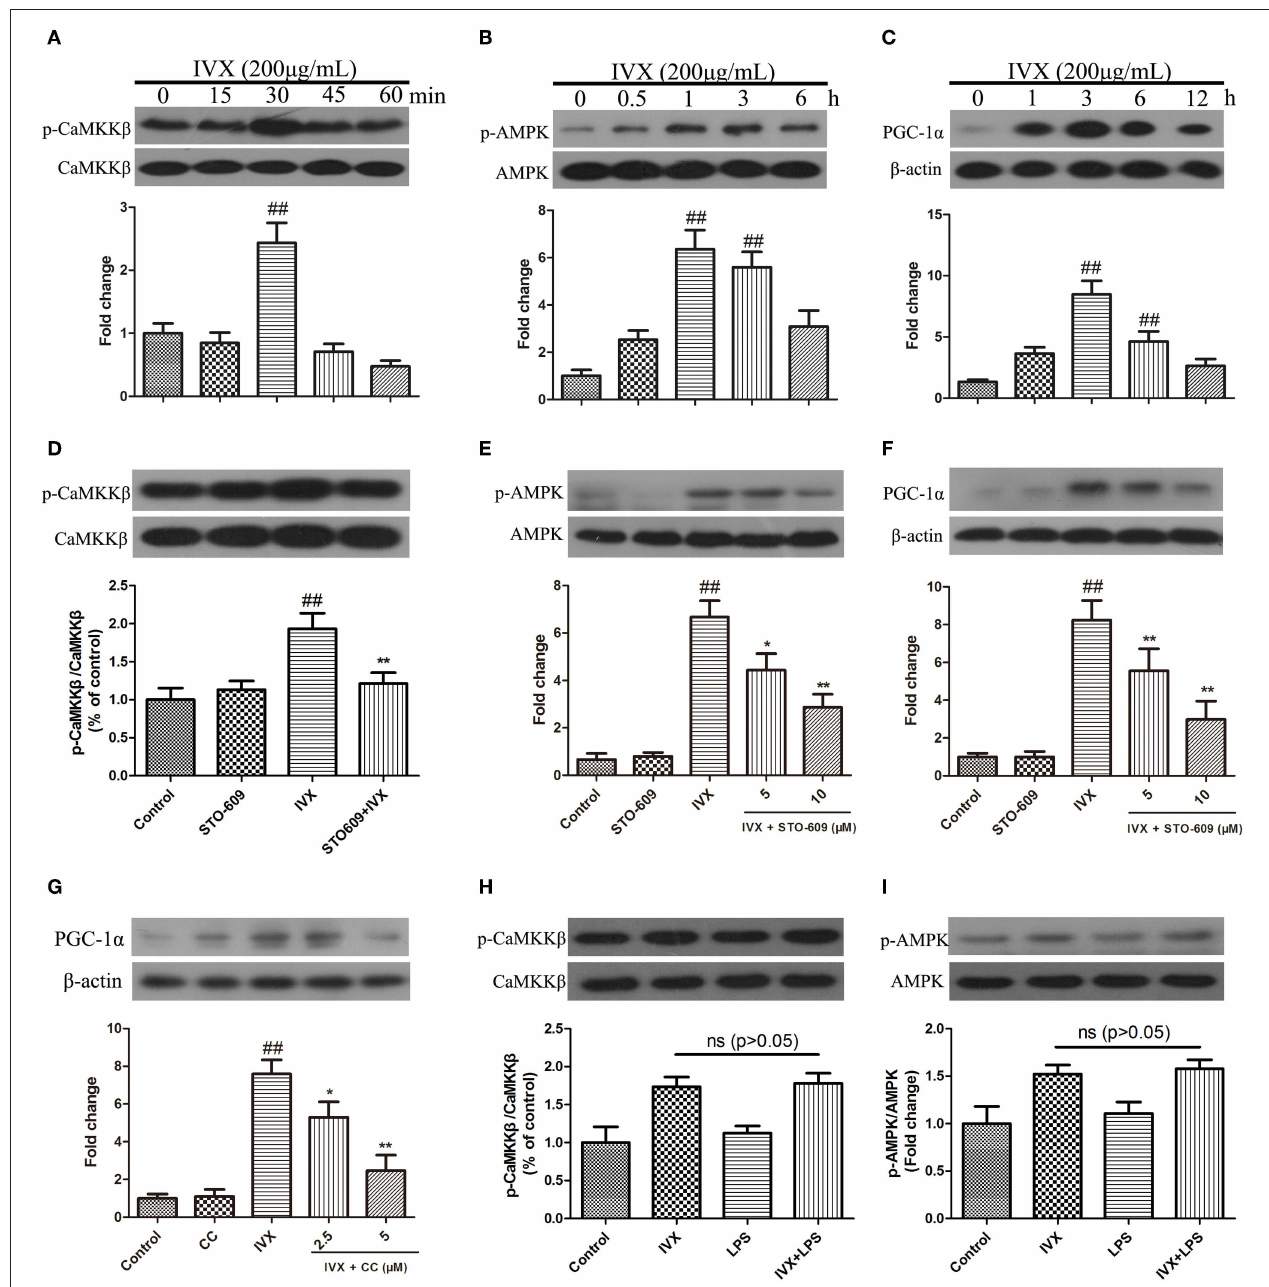
FIGURE 5 | IVX enhanced the expression of PGC-1 α via the CaMKK β -dependent AMPK signaling pathway in BV-2 cells. (A–C) BV-2 cells were treated with IVX (200 µ g/mL) for different time. Cells were then harvested and the protein expression of p-CaMKK β (A) , p-AMPK (B) , and PGC-1 α (C) was detected by western blotting. (D) BV-2 cells were treated with 10 µ M of STO-609 (a CaMKK β inhibitor) for 2h and then treated with IVX for 30min, the protein expression of p-CaMKK β was detected by Western blotting. (E) Cells were pretreated with STO-609 (5 and 10 µ M) for 2h, followed by stimulation with IVX (200 µ g/mL) for 1h. The protein expression of p-AMPK and AMPK were detected by western blotting. (F) BV-2 cells were pretreated with the STO-609 (5 and 10 µ M) for 2h, followed by stimulation with IVX (200 µ g/mL) for 3h. The protein expression of PGC-1 α was detected by western blotting. (G) Cells were pretreated with the 2.5 and 5 µ M Compound C (CC, an AMPK inhibitor) for 2h, and then treated with IVX (200 µ g/mL) for 3h. The protein expression of PGC-1 α was determined by western blotting. (H) After treatment with IVX (200 µ g/mL) and IVX (200 µ g/mL) + LPS (100ng/mL) for 30min, the protein expression of p-CaMKK β was investigated. (I) After treatment with IVX (200 µ g/mL) and IVX (200 µ g/mL) + LPS (100ng/mL) for 3h, the protein expression of p-AMPK was investigated. β -actin was utilized as an internal control and the experiments were conducted in triplicate and repeated at least three times. Values are expressed as mean ± SEM ( n = 4 in each group). ## p < 0.01, vs. control group; * p < 0.05 and ** p < 0.01 vs. IVX